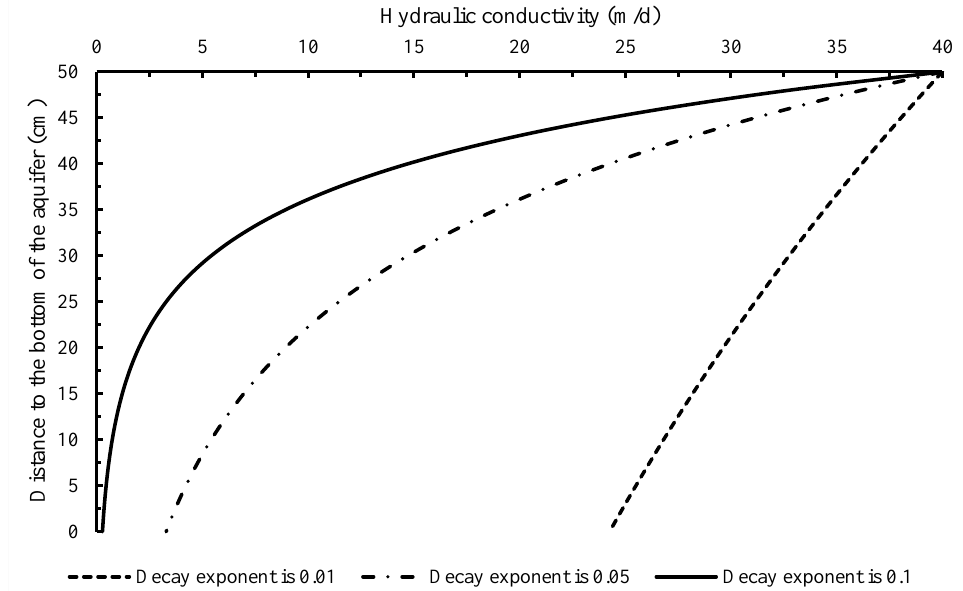
Figure 4. The exponential relationship between hydraulic conductivity and depth.